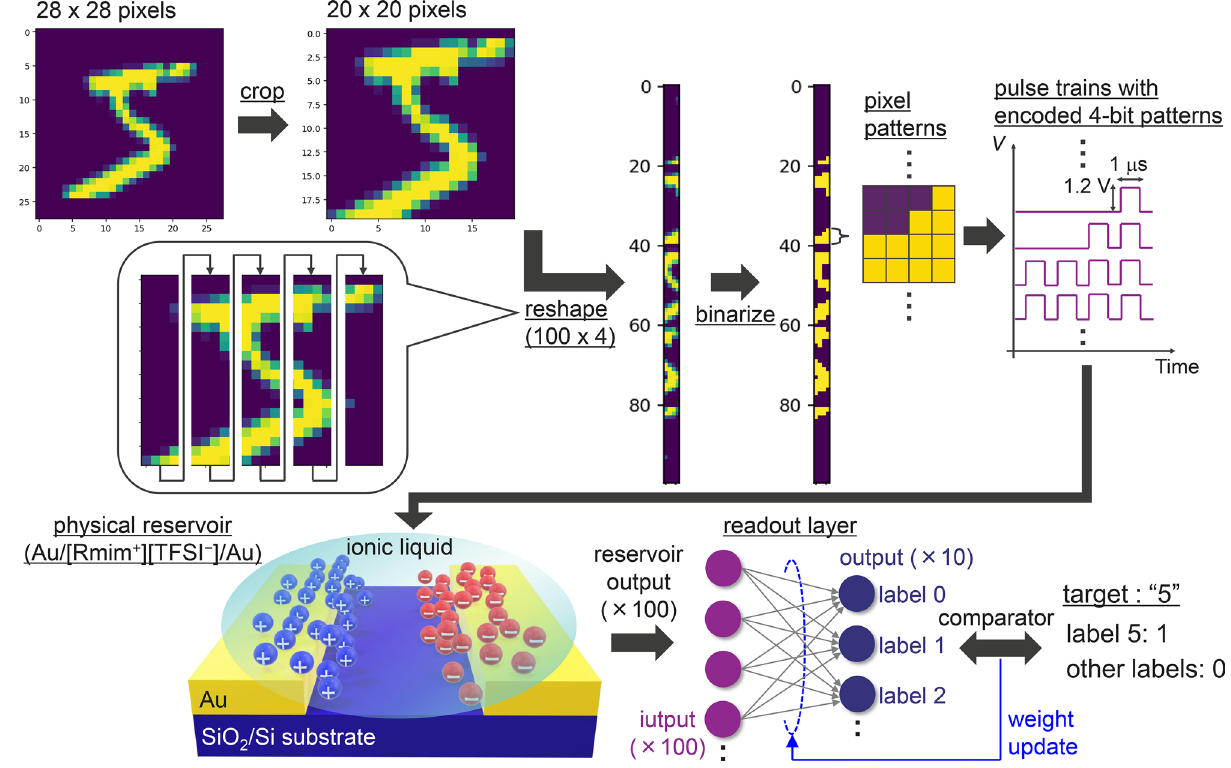
Figure 5. Schematic of the data-processing sequence for the image classification task in this study.